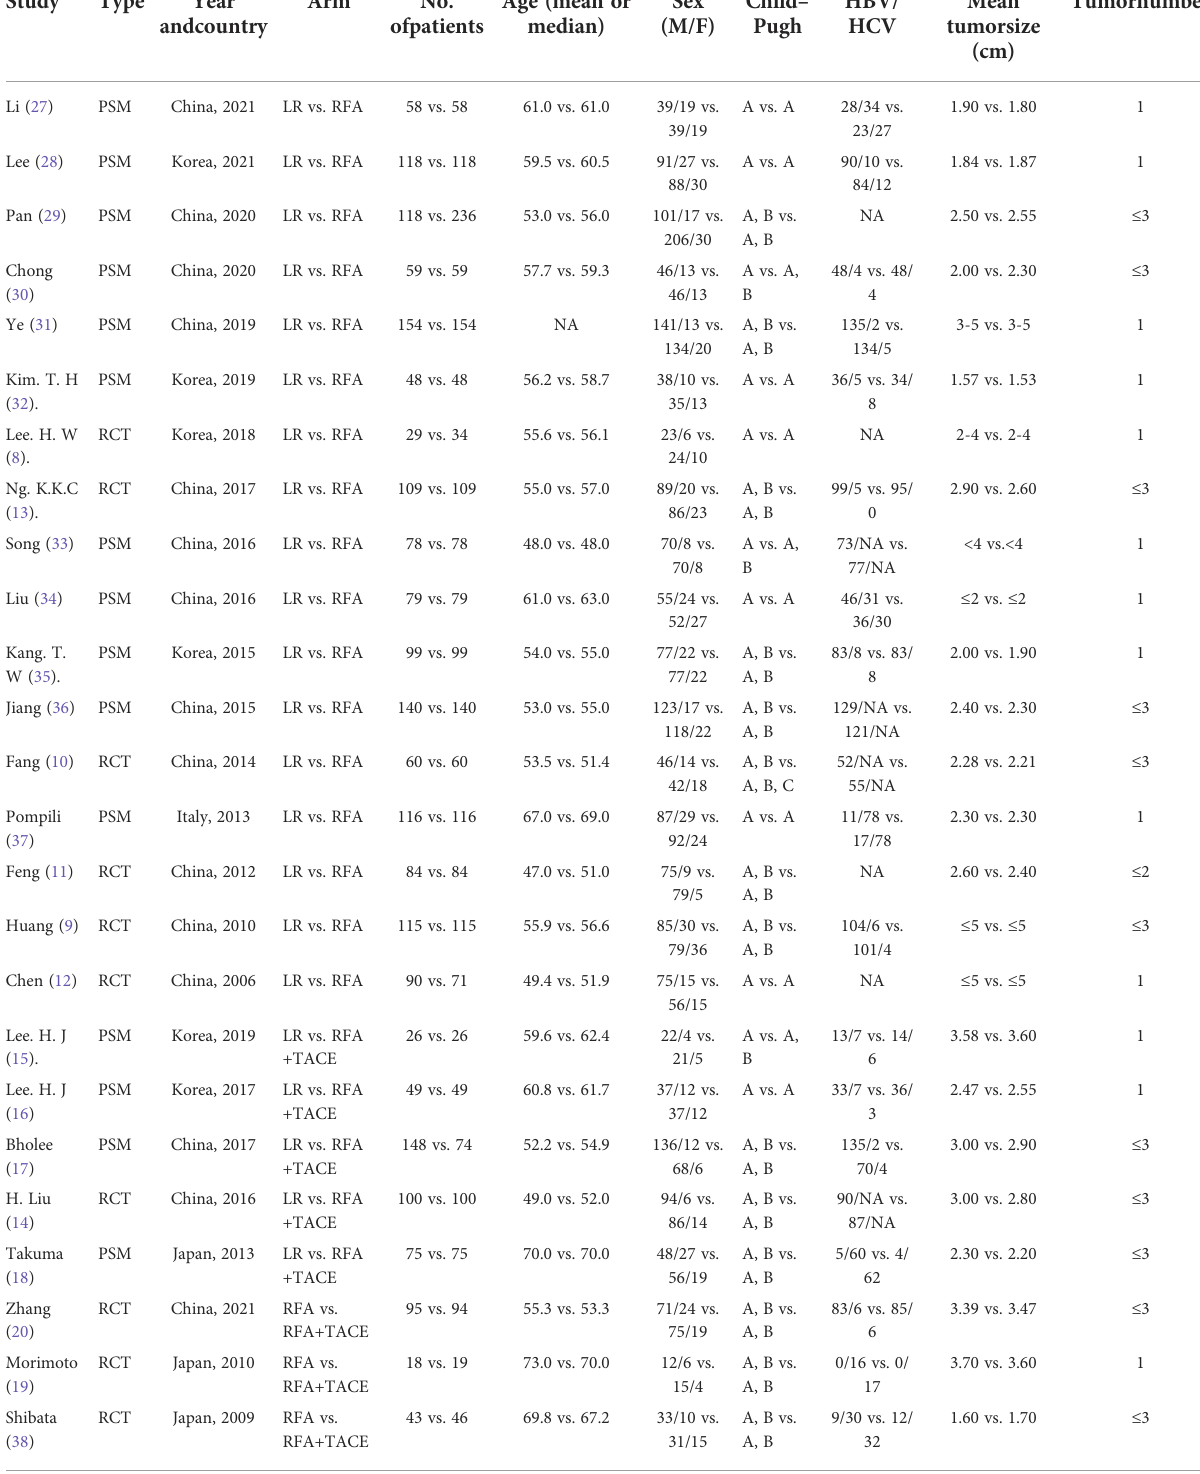
TABLE 1 A list of all included